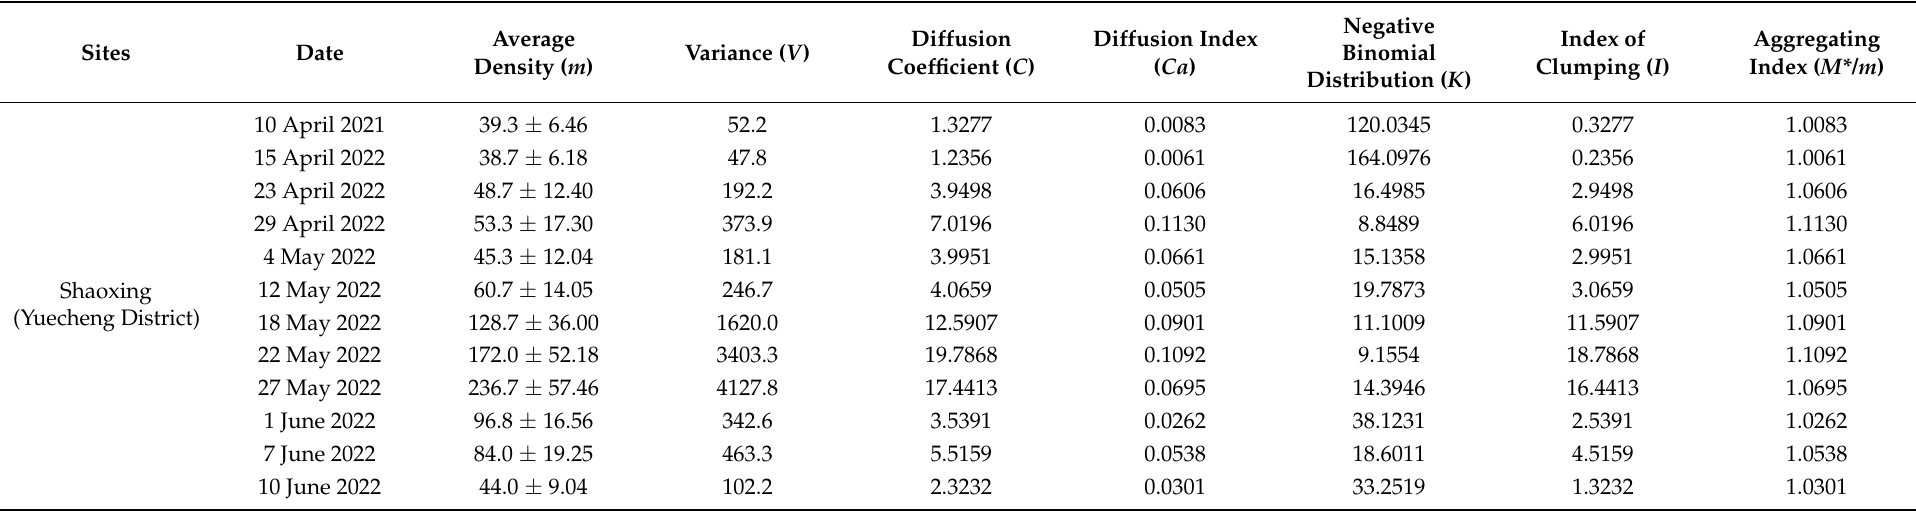
Table 2. The aggregation indexes of D. minowai nymphs on leaves in tea plantations in Zhejiang Province, China.